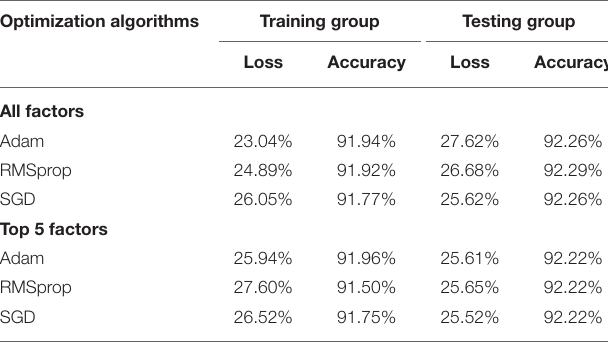
TABLE 4 | Model loss and accuracy for deep-learning sequential model using three optimizers in both training and testing